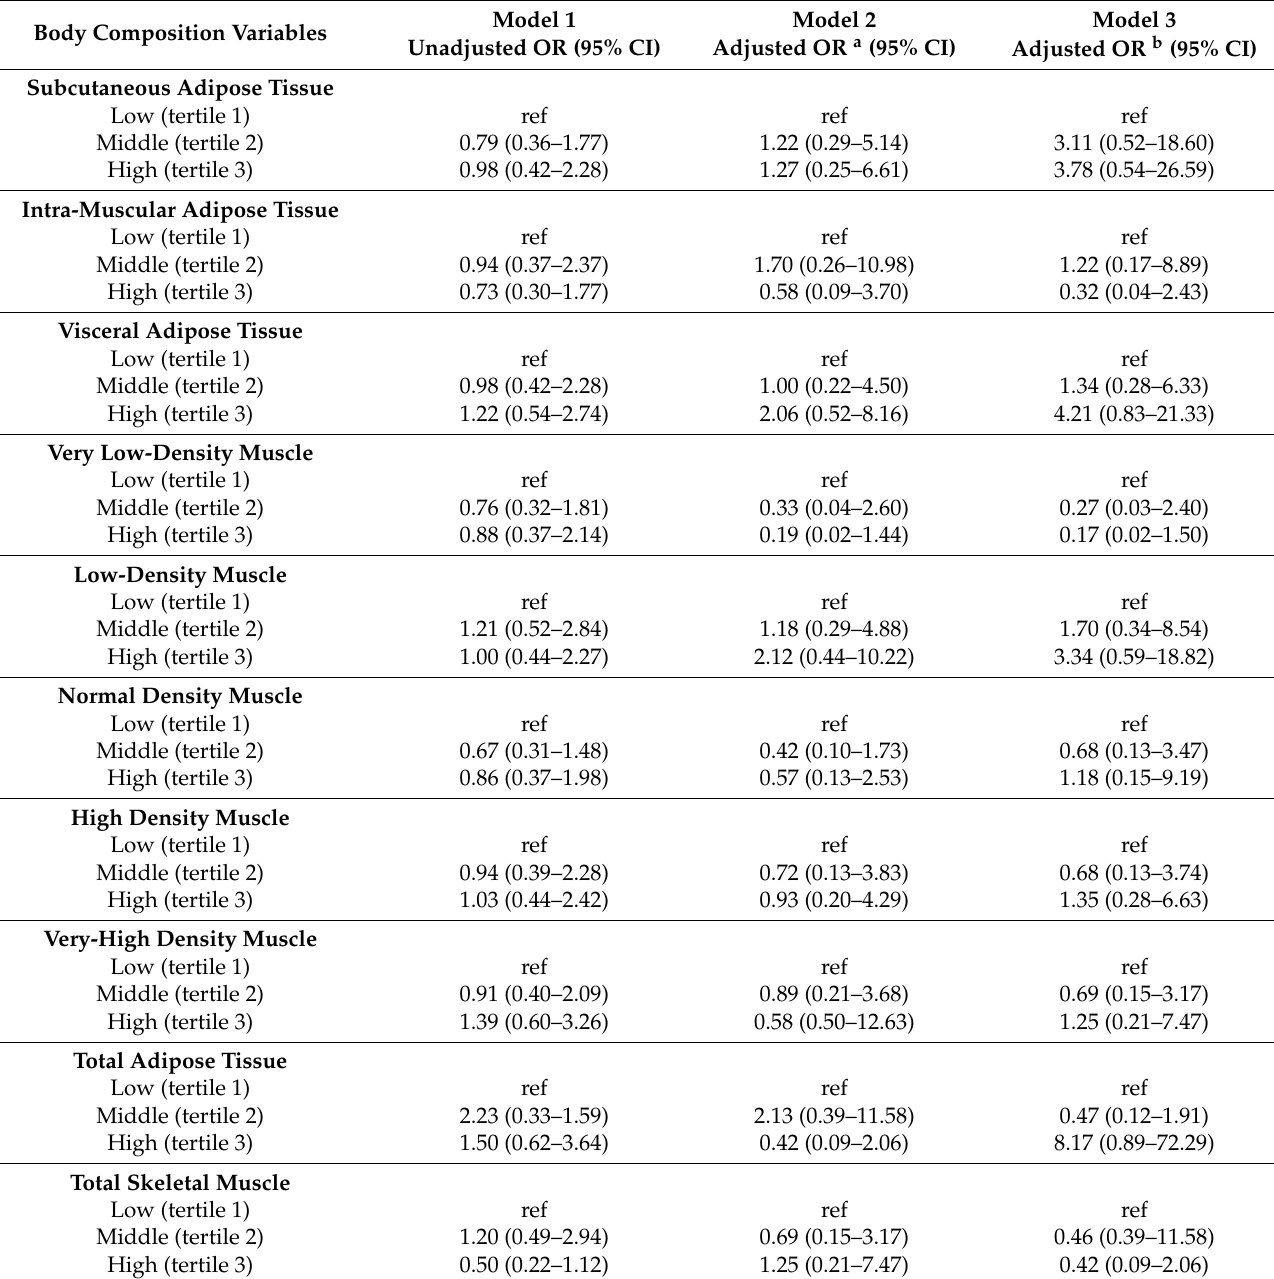
Table 4. Odds ratio (95% CI) for the association between specific body composition components and TNBC subtype among postmenopausal women ( ≥ 55